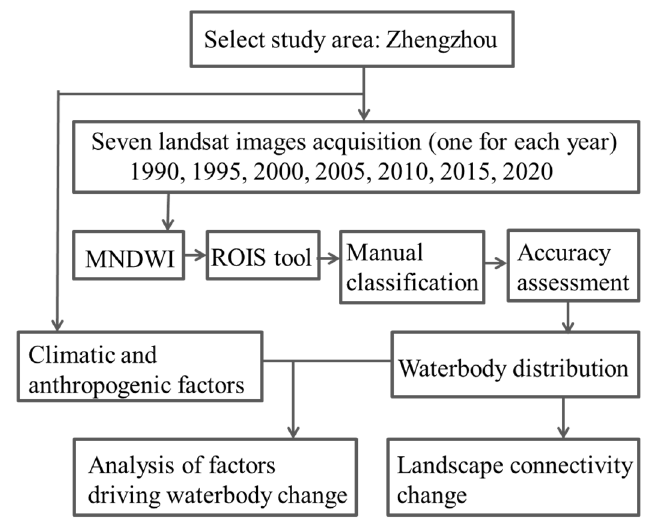
Figure 2. Workflow steps in our analysis.